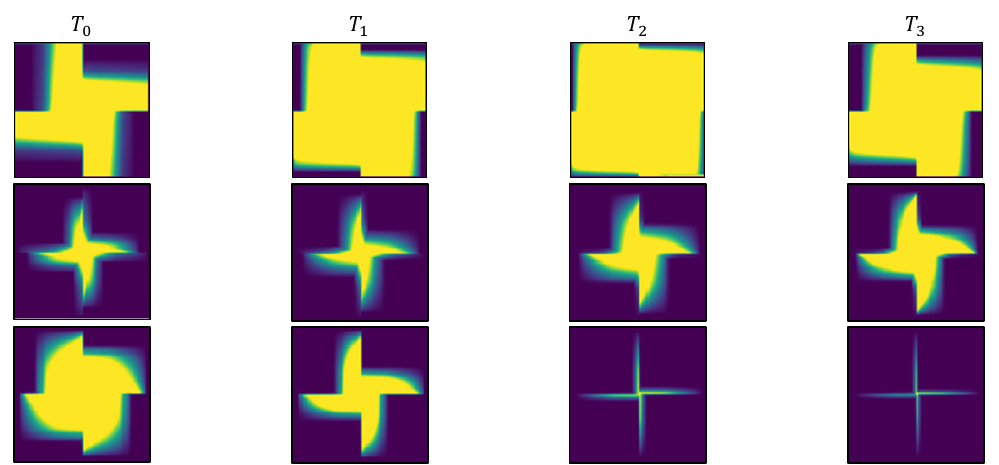
Figure 8. 𝐵𝐼𝐷𝑃 (cid:3006)(cid:2870) examples of 2nd enhanced 𝐵𝐼𝐷𝑃 (cid:3006)(cid:2869) . Figure 8. BIDP E 2 examples of 2nd enhanced BIDP E 1